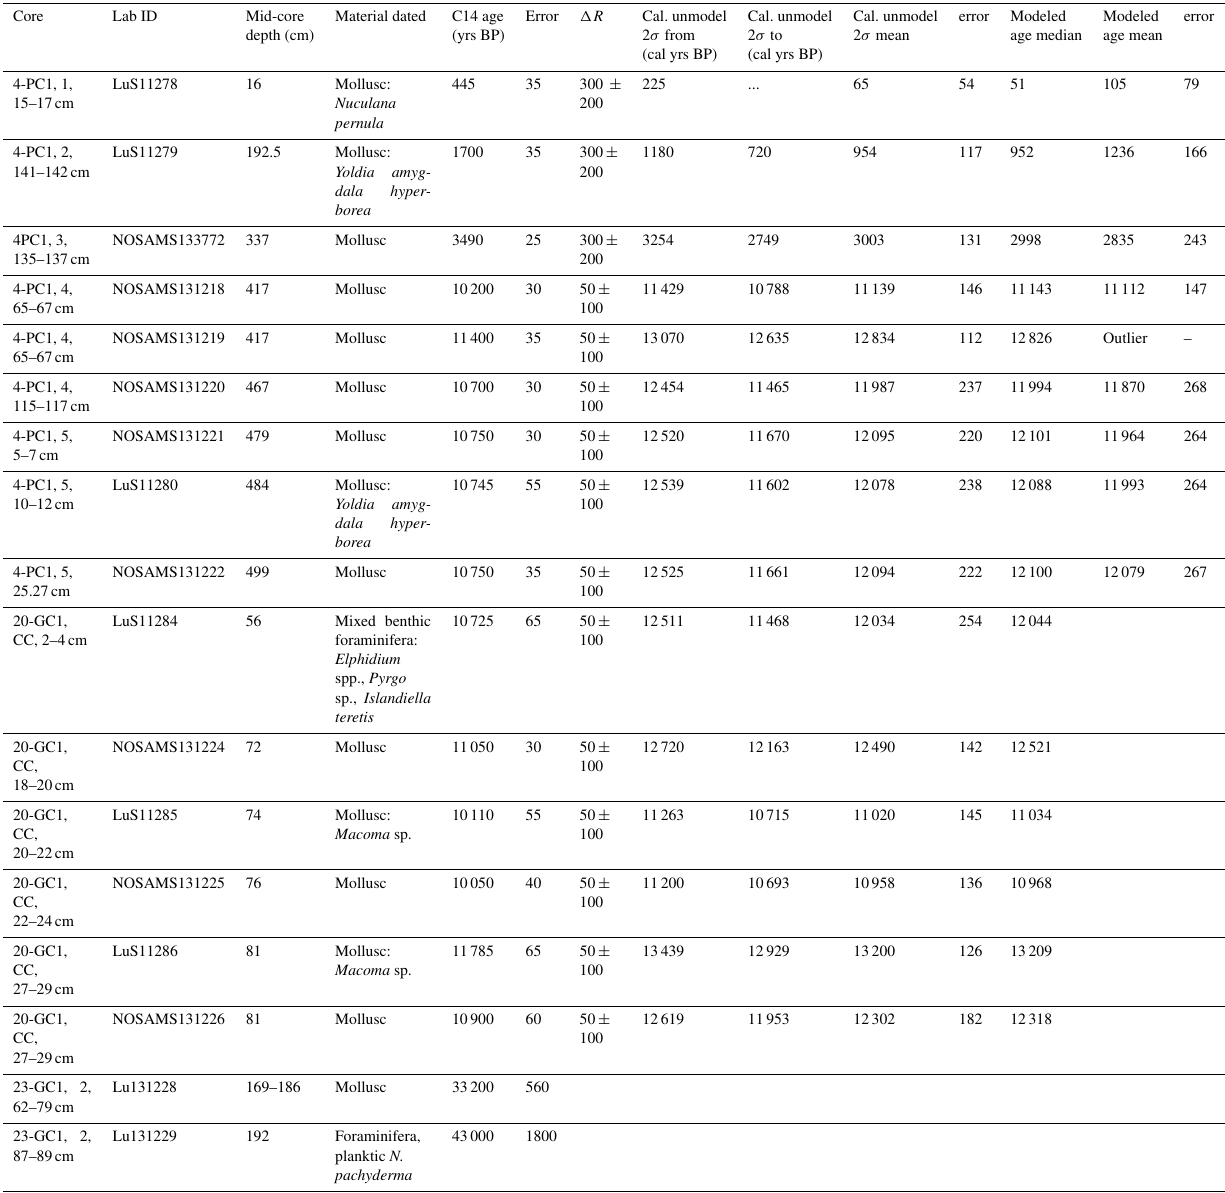
Table 2. Radiocarbon ages calibrated from SWERUS-C3 Leg 2, 4-PC, 20-GC, 23-GC, and 24-GC. Core Lab